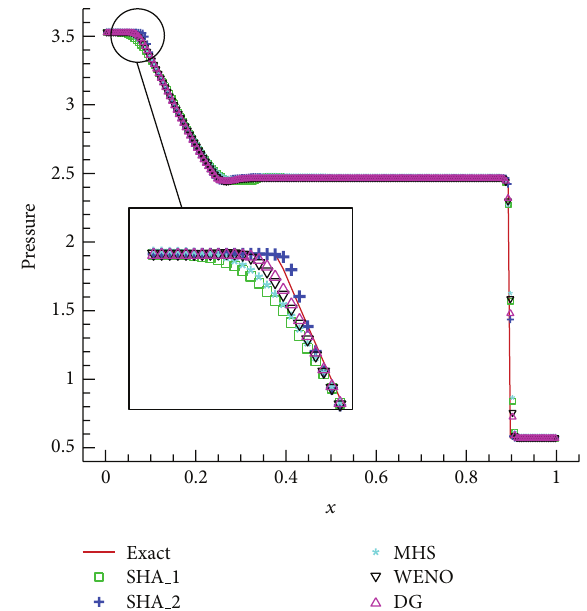
Figure18:Pressurecomparisonofschemesattime0.16unitsforLax